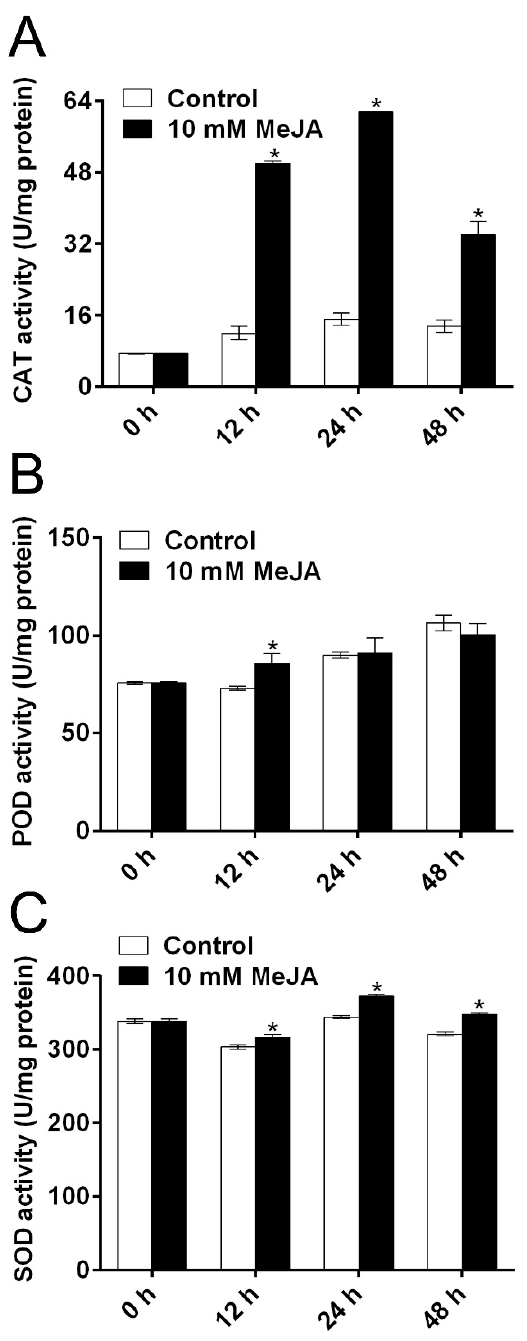
Figure 3. The modulation of MeJA treatment on antioxidant enzyme activities in cassava tuberous roots during PPD. Related activities of catalase (CAT) ( A ), peroxidase (POD) ( B ), and superoxide dismutase (SOD) (C) in cassava tuberous roots. Data are means ± SD calculated from at least four biological replicate samples. Asterisk symbols (*) indicate significant differences according to Duncan’s multiple range test at p < 0.05 at the same time.